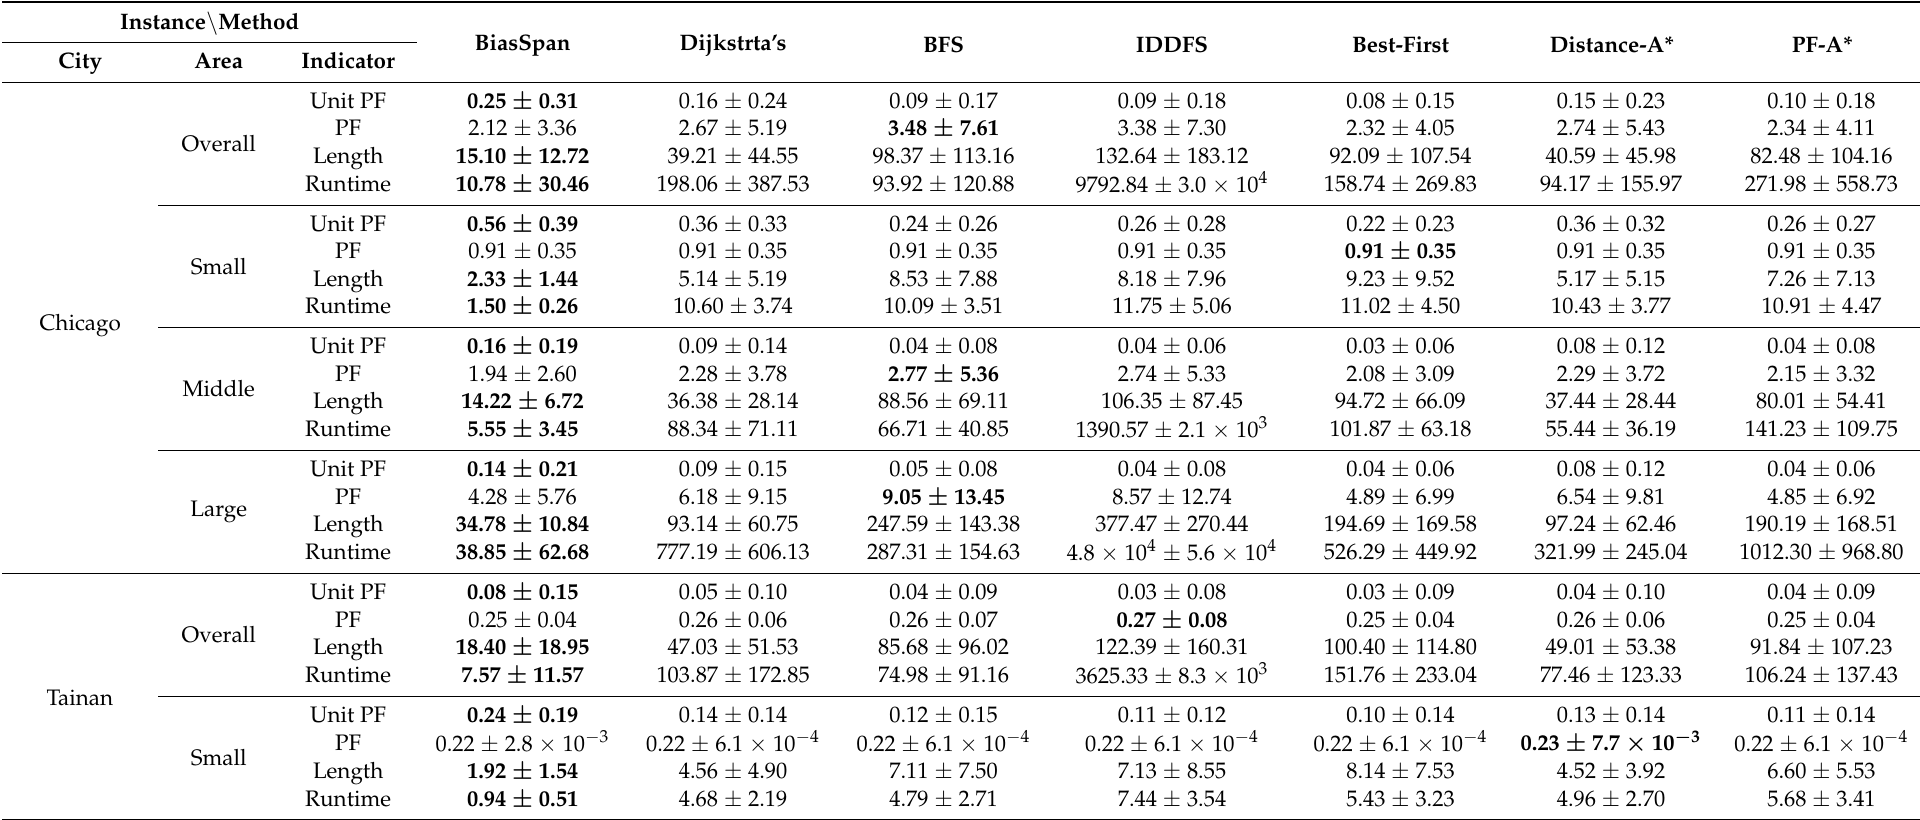
Table 4. Performance for unit PF (to be maximized), PF (to be maximized), length (to be minimized), and runtime in mean and standard deviation of solutions derived from each method under different datasets and area ranges (small for <10 km 2 ; middle for 10~100 km 2 ; large for >100 km 2